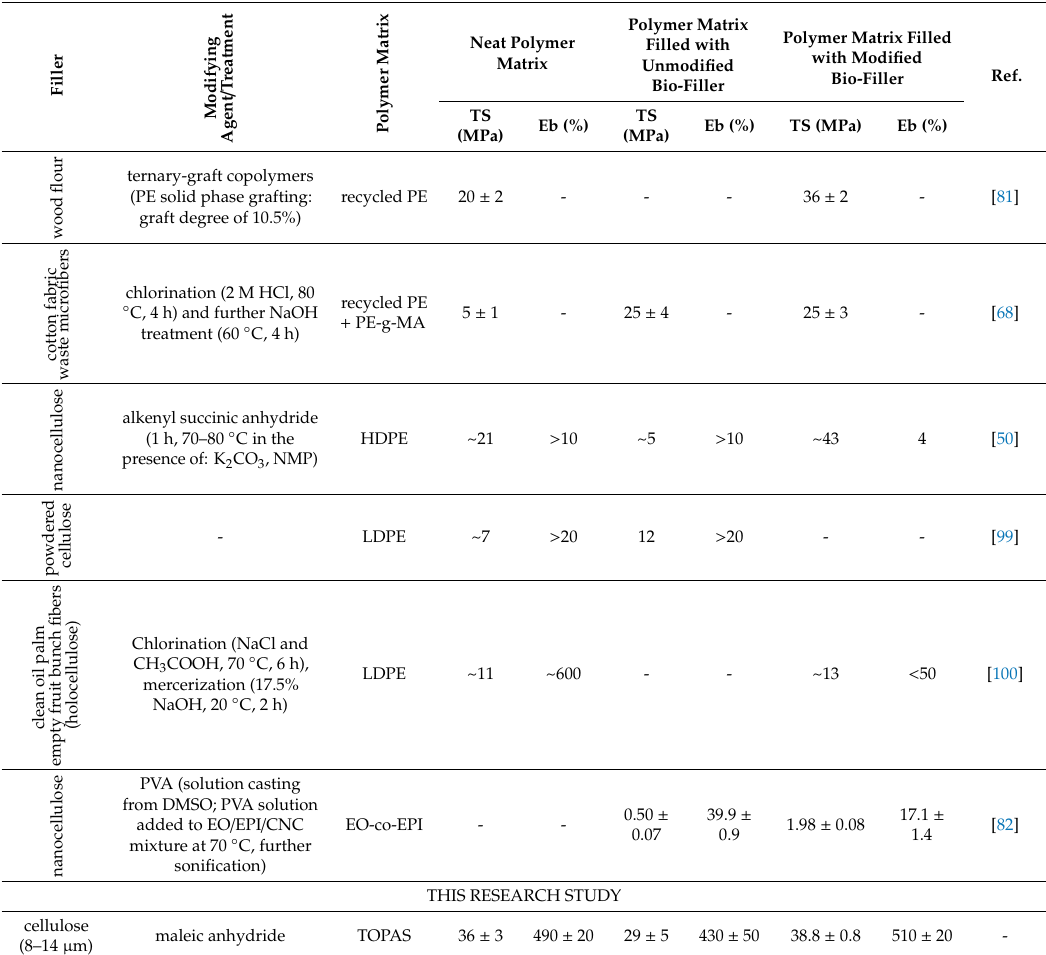
EO-co-EPI THIS RESEARCH